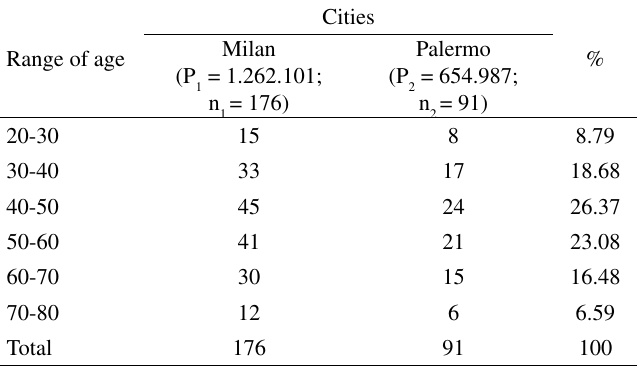
Table 1 - Sample stratification and sub-samples by range of age and cities (based on Population Strata size) Range of age